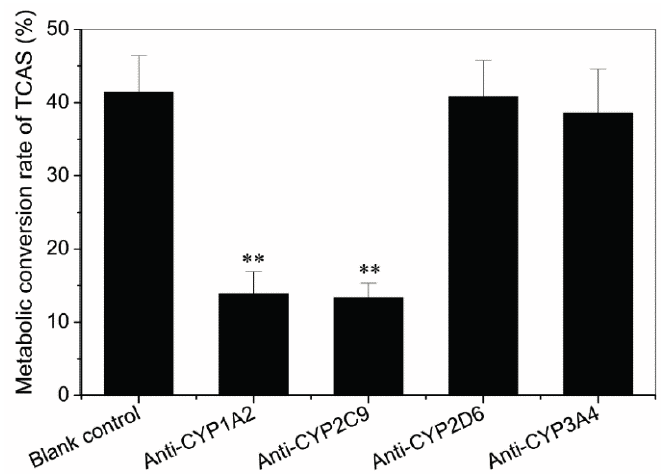
Figure 3. Metabolic conversion rate of TCAS in human liver microsomes plus monoclonal antibodies. Values are presented as M ± SD (n = 3). (* p < 0.05, ** p < 0.01, compared with blank control).